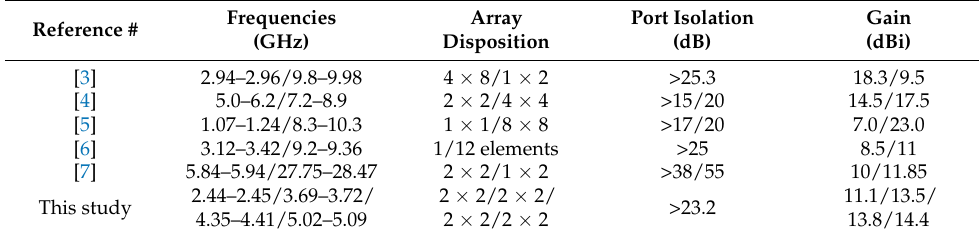
Table 3. Frequencies, array disposition, port isolation, and gain of shared aperture array antennas.